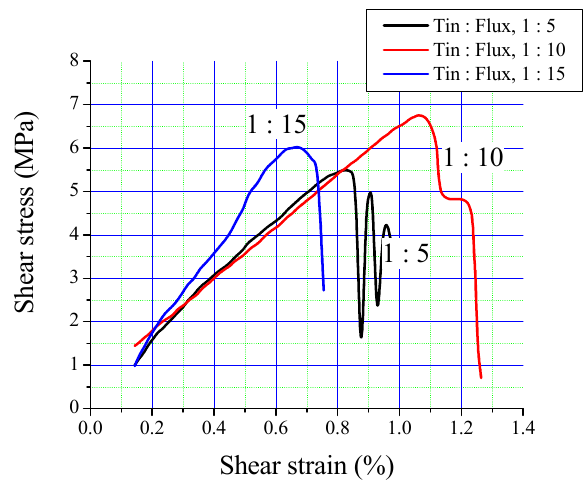
Figure 9. Interfacial shear strength values of bimetallic specimens containing di ff erent Sn-to-flux ratios.